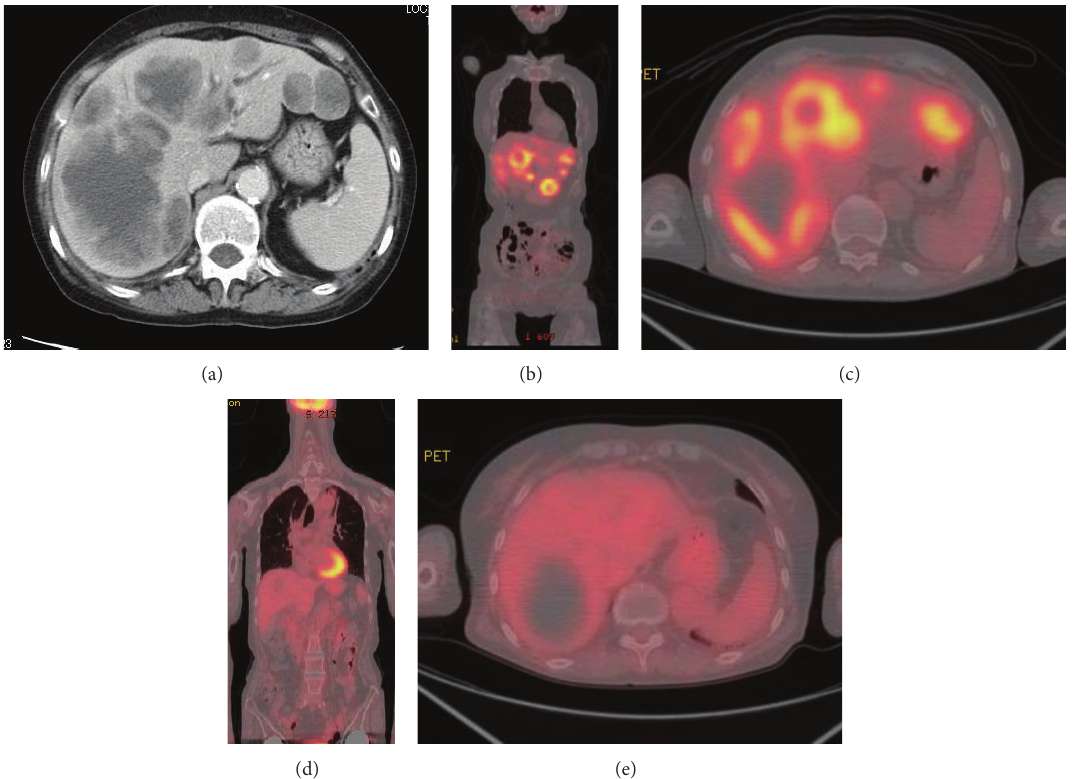
Figure 1: Enhanced CT images and positron emission tomography/computed tomography (PET/CT) before ((a)–(c)) and after ((d), (e))